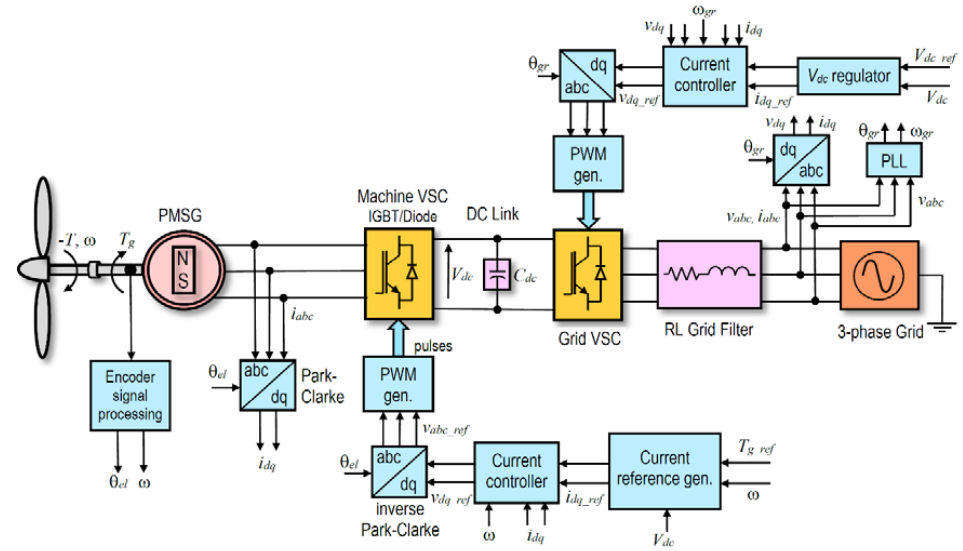
Figure 1. Configuration of a gearless permanent magnet synchronous generator (PMSG)-based wind energy conversion system (WECS) connected to a grid through back-to-back voltage source converters (VSCs) with schematic block diagram of the converters’